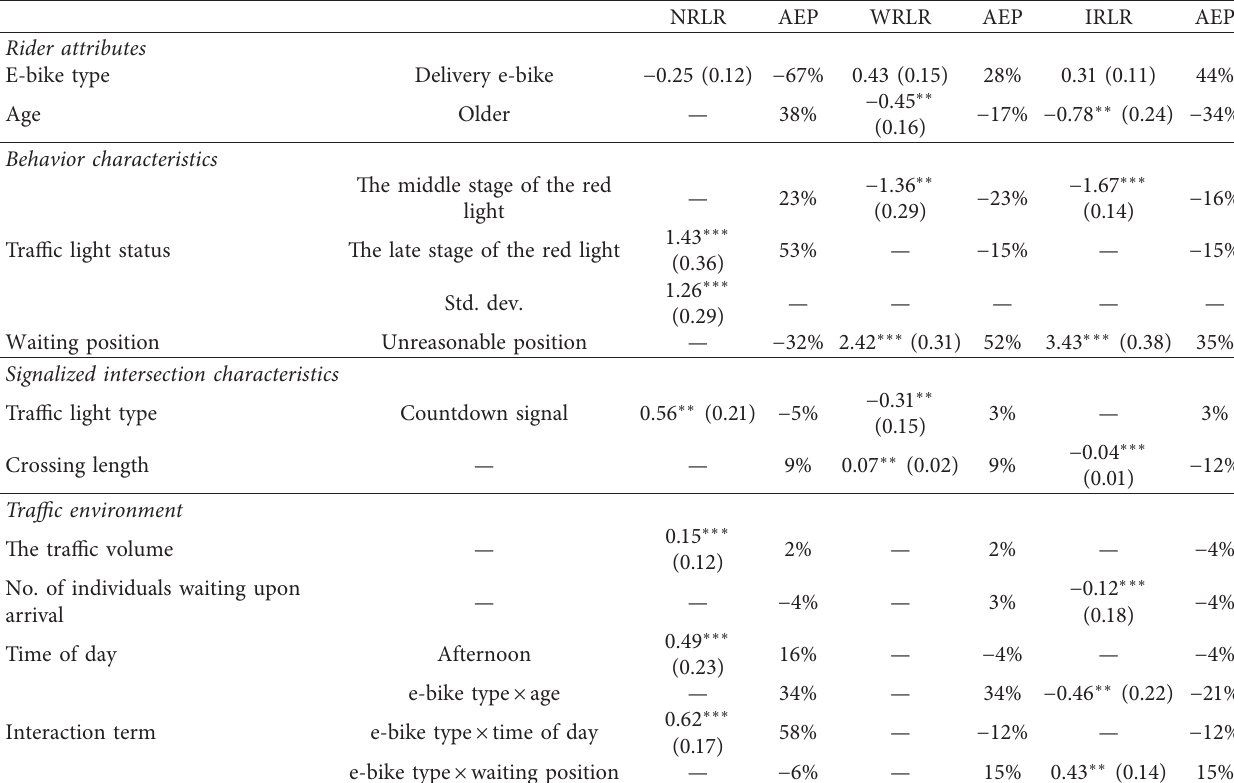
Table 5: Random parameter logit model estimation results (with interaction